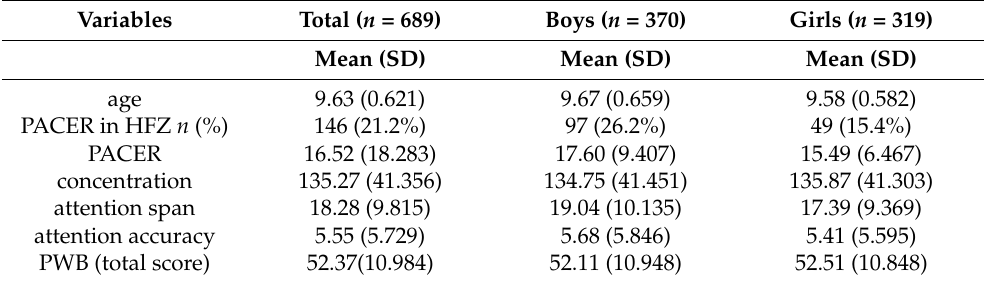
Table 1. Descriptive statistics of the variables for the total sample and by gender. Variables Total ( n = 689) Boys ( n = 370) Girls ( n = 319) Mean (SD) Mean (SD) Mean (SD) PACER in HFZ n (%) 146 (21.2%)